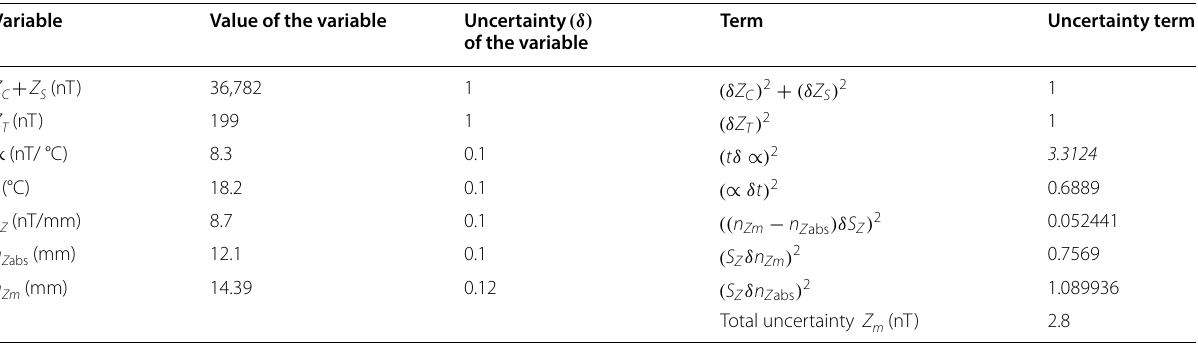
Dominant term is emphasized in italics